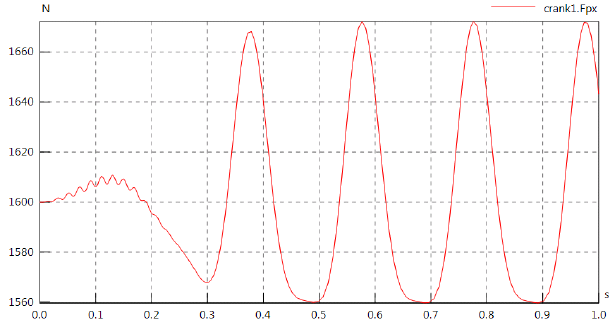
Figure 4. A graph of the longitudinal force acting on the slider for the synthesized machine with a slider-crank